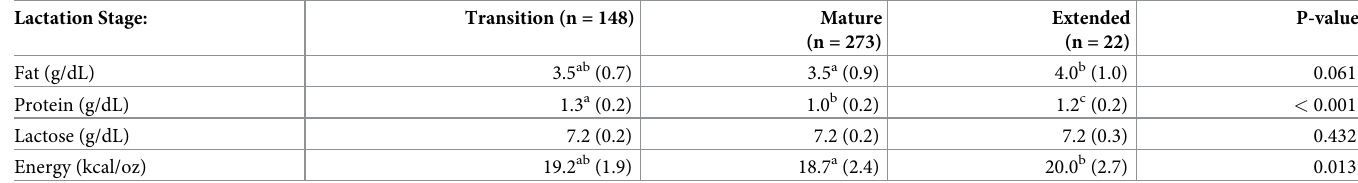
Notes: Nutrient data represent mean and standard deviations. Differences by Lactation Stage were evaluated using a one-way ANOVA and Tukey test for multiple comparisons. Values with the same letter in the superscript are not statistically different (P >